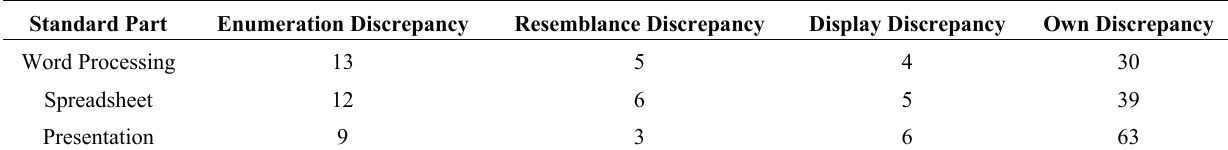
Table 3. Discrepancy distribution of OOXML and UOF.